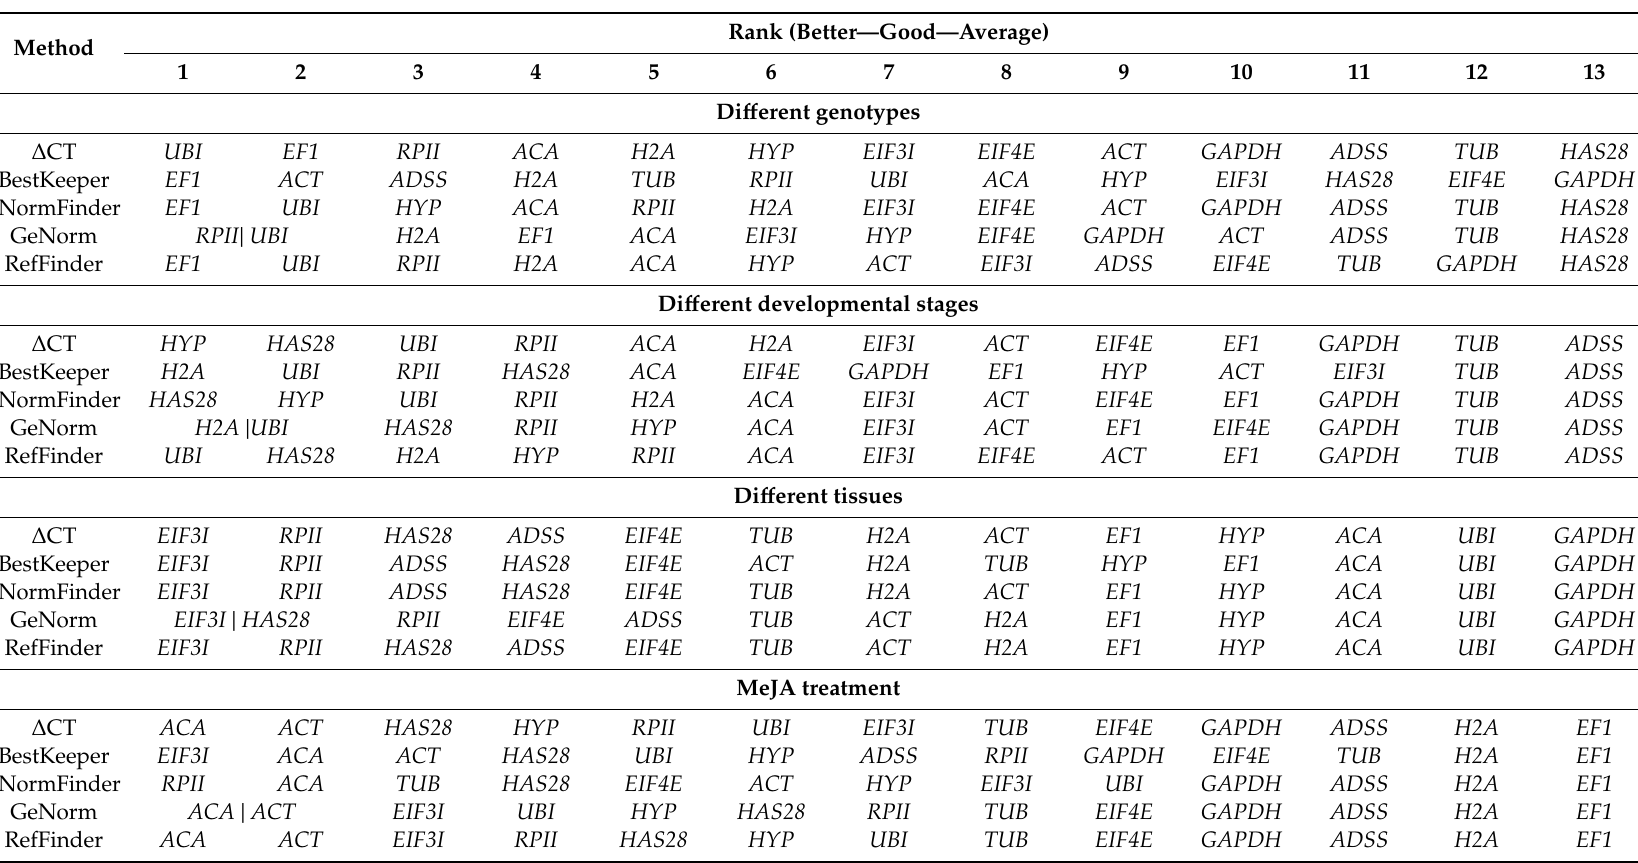
Table 2. The ranking of thirteen reference genes according to the ∆ Ct method and the BestKeeper, NormFinder, geNorm, and RefFinder programs.